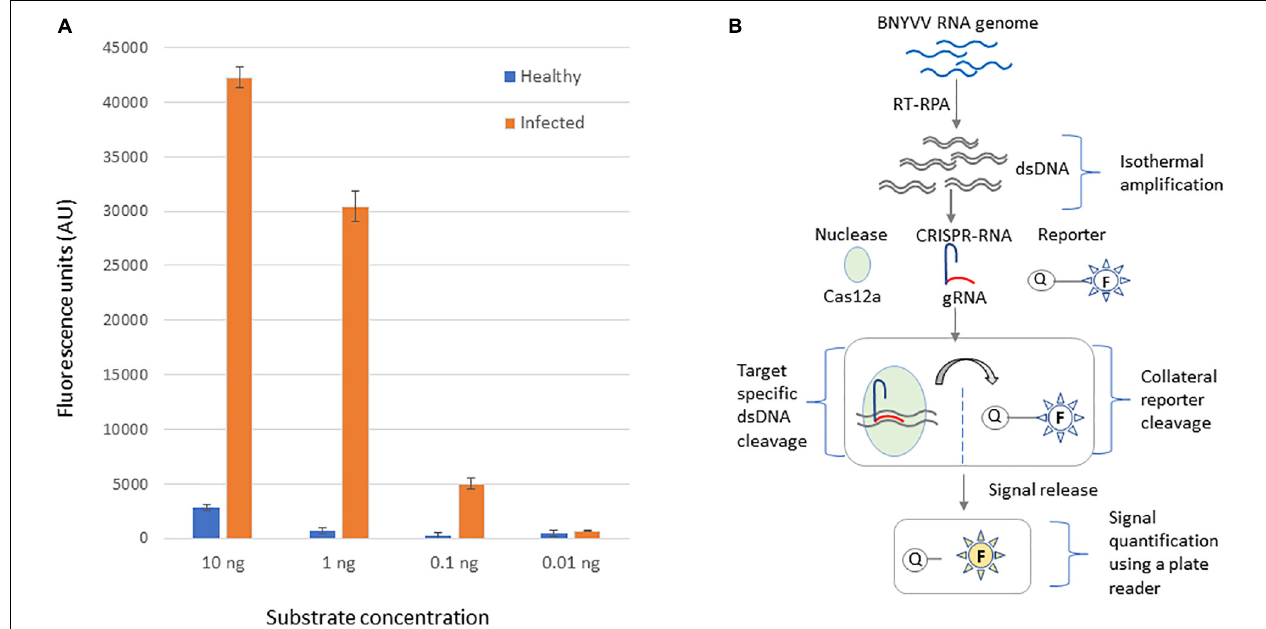
FIGURE 4 | CRISPR-Cas12-based detection of BNYVV in root tissue of B. vulgaris baited for rhizomania using infected field soil. (A) The template DNA used in this assay was obtained through RT-RPA from rhizomania-infected and healthy roots of sugarbeet. To determine the limit of detection, the RT-RPA product was diluted and subjected to CRISPR-Cas12a reporter assay as described in the Materials and methods section. No template reaction serves as the negative control and was used for background subtraction. Values plotted on the y -axis represent background-subtracted fluorescence, and x -axis represents dilution concentrations of the RT-RPA-generated template DNA. Error bars represents standard deviation (STDEV) on replicates ( n = 3). (B) Schematic illustration of step-by-step processes involved in the development of CRISPR-Cas12a-based BNYVV diagnostics for rhizomania in sugarbeet roots.